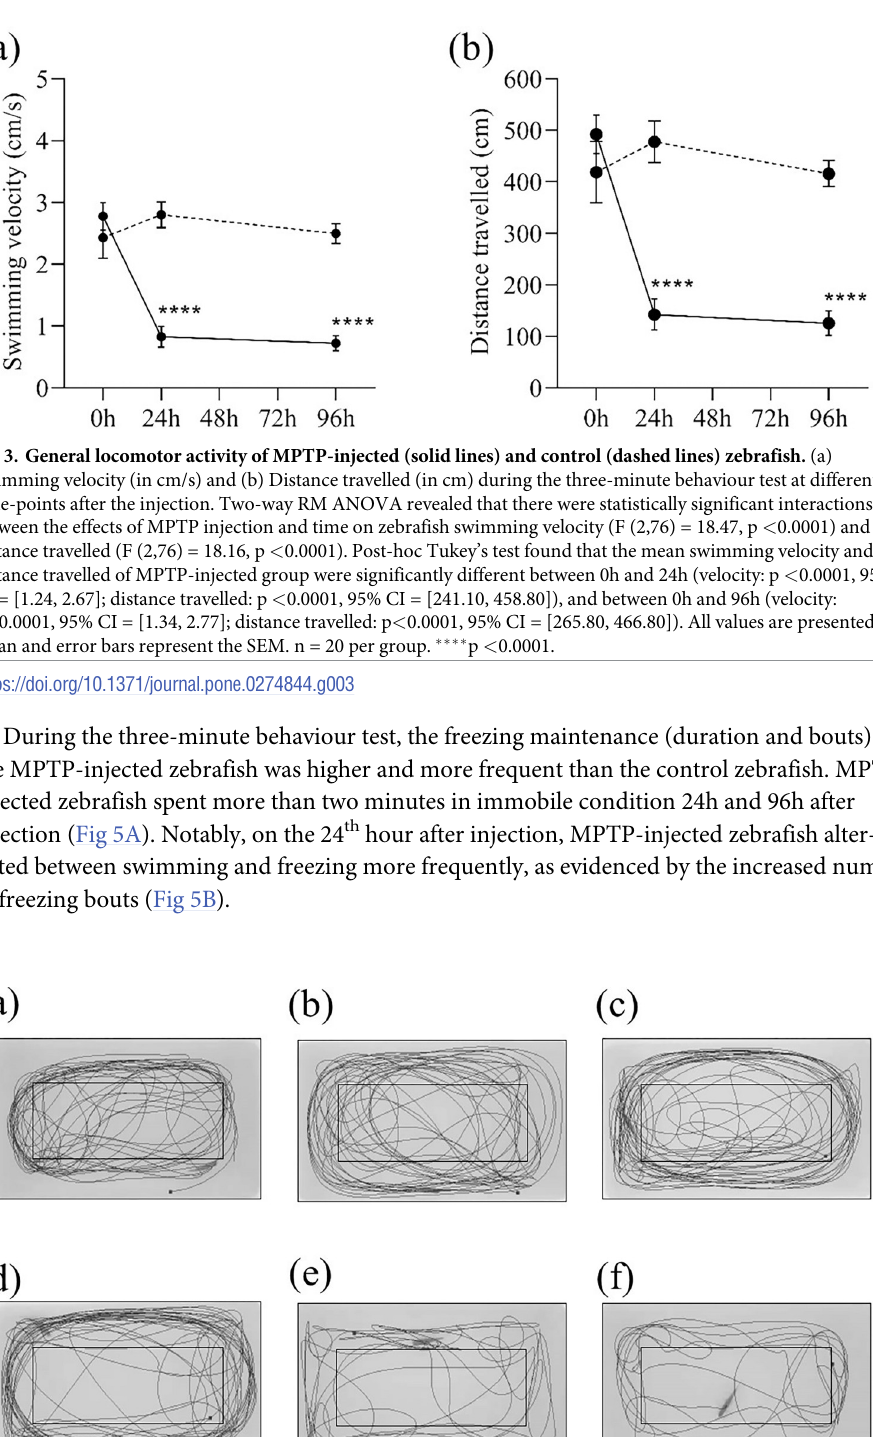
Fig 4. Graphical representation of the swimming paths (in black) of the MPTP-injected and control zebrafish. The outer rectangular border outlining the assay tank and the inner rectangle separate the IN and OUT zones. Each figure represents (a) Control, 0h. (b) Control, 24h. (c) Control, 96h. (d) MPTP-injected, 0h. (e) MPTP-injected, 24h. (f) MPTP-injected, 96h. The paths were generated by the EthoVision XT tracking software.